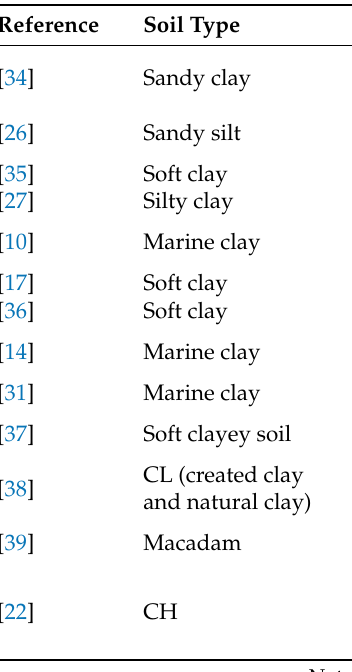
Table 1. Key references on the performance of soilcrete under temperate